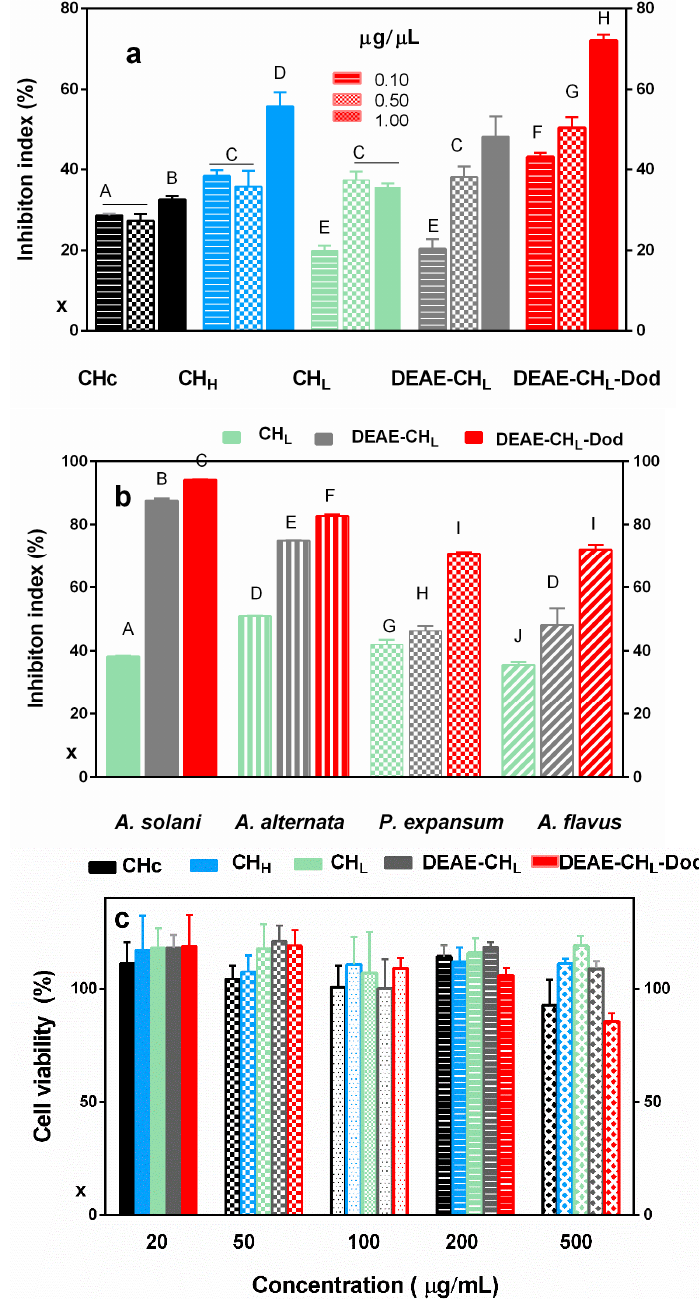
Figure 8. ( a ) Effect of concentration on the inhibition index of Aspergillus flavus and ( b ) Comparative antifungal activities of low Mw chitosans at 1.0 g/L against Alternaria alternata, Alternaria solani, Penicillium expansum, and A. flavus ( c ) NHI 3T3 cells viability as a function of polymer concentration.